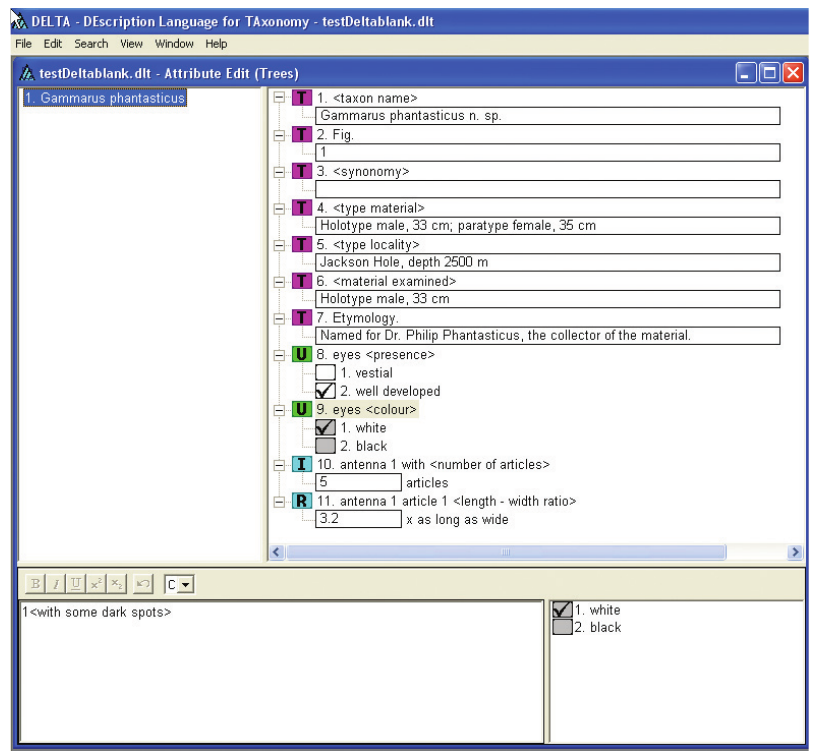
Figure 12. Recording the character states in the tree–like expanded character pane. It is possible to add comments in angle brackets, and other qualifying information, in the lower left pane.